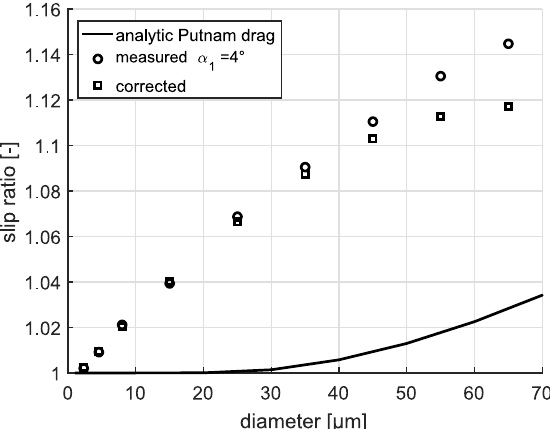
Figure 5. Calculated Putnam drag-based relaxation of different droplet classes at the inlet plane and resulting slip ratio maxima.